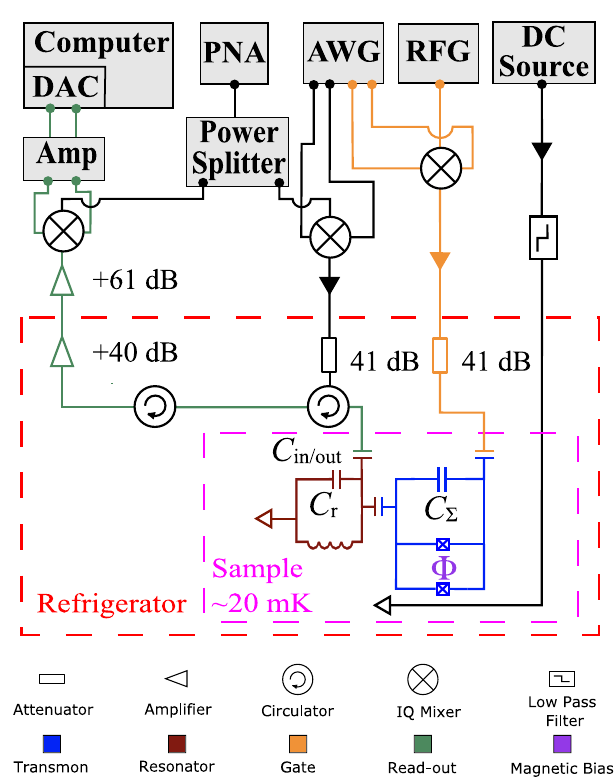
Fig. 8 | Experimental setup. Schematic of the experimental setup used in this work,includingthetransmoncircuit ’ sintegrationwiththedilutionrefrigeratorand microwave